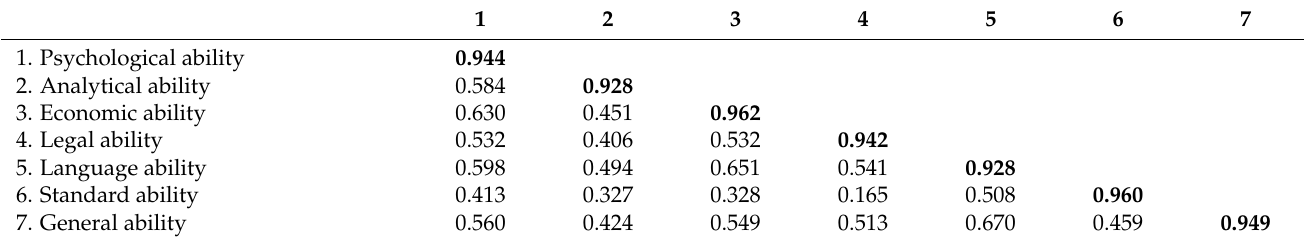
Table 6. Fornell–Larcker criterion analysis for discriminant validity.